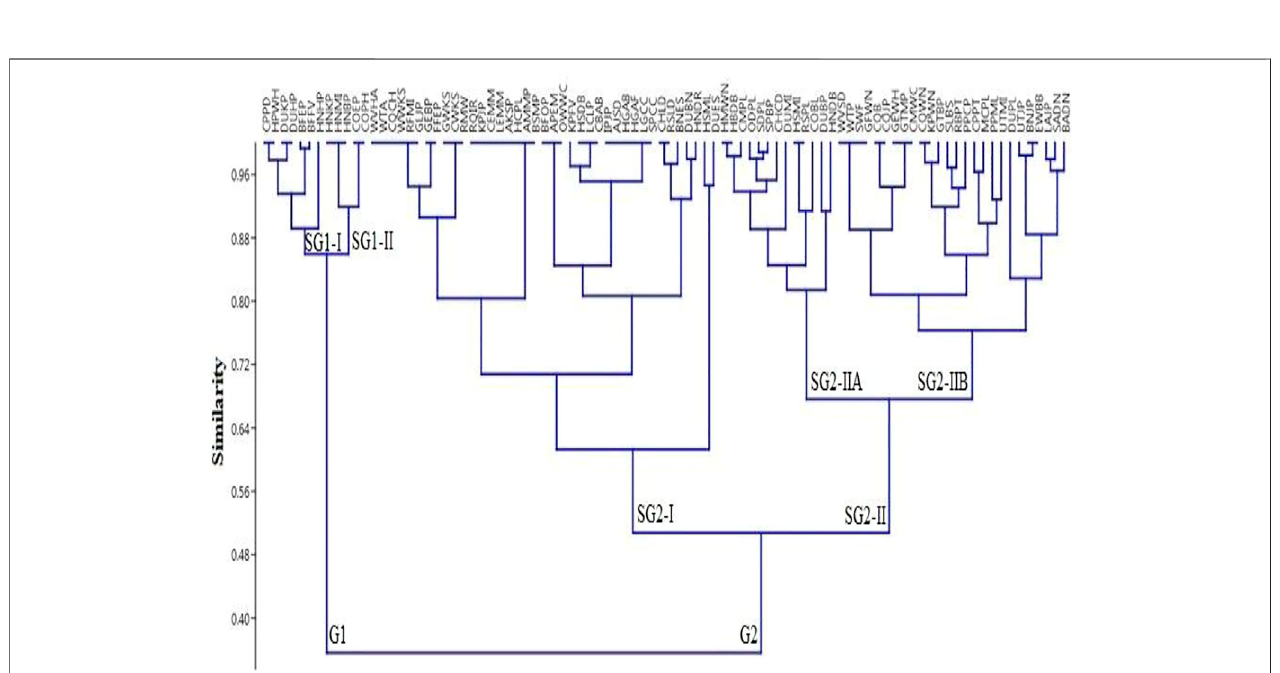
Frontiers in Pharmacology |